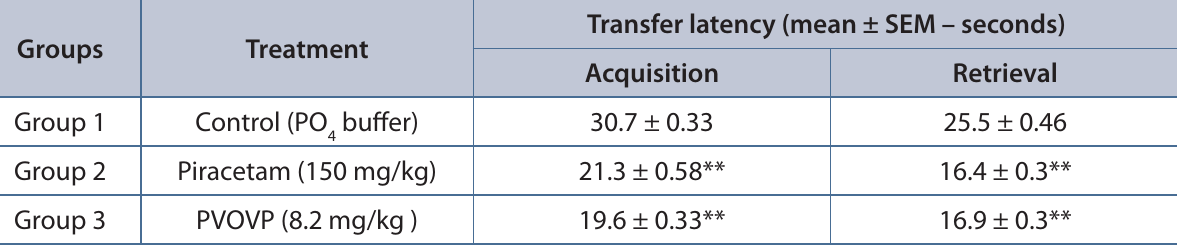
Table 2. Effect of photooxidized Vespa orientalis venom protein on transfer latency in elevated plus maze Groups